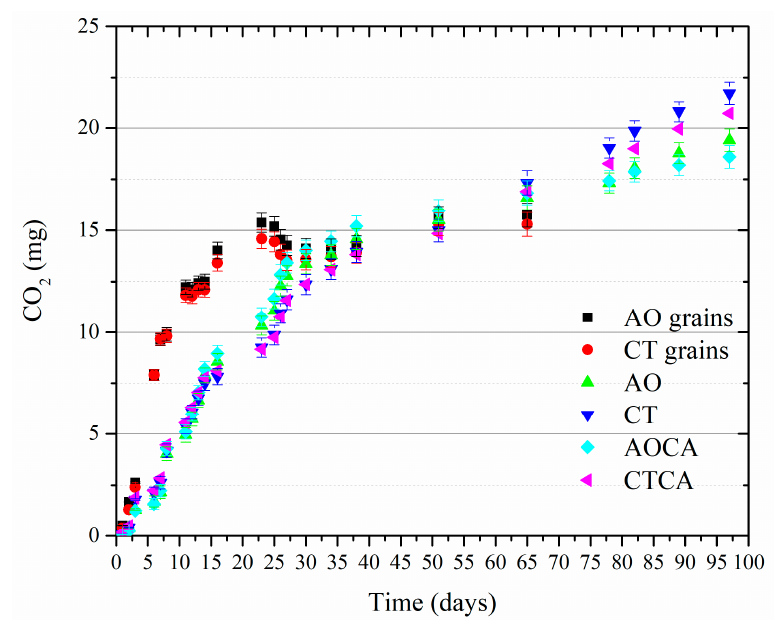
Figure 6. CO 2 release during the biodegradation test of AO and control grain and bioplastics protopypes. The data has been subtracted from the soil reference data.